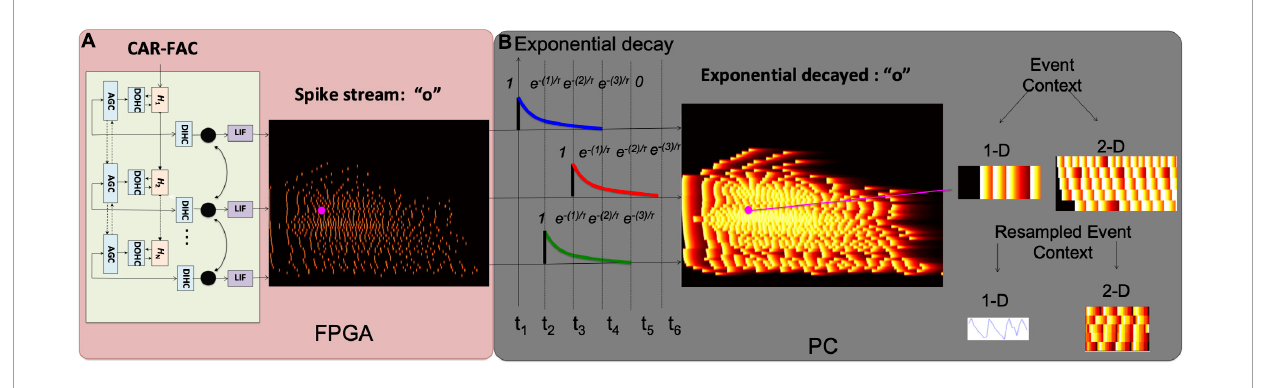
FIGURE3 Construction of the auditory time surface window. (A) Spike streams generated from the binaural CAR-FAC system on FPGA; (B) when a spike occurs in a frequency channel, the value decays exponentially as t increases, forming the exponential decaying feature. A 1-D/2-D event context (E_C) is generated on a local neighborhood centered on the current event (in magenta). The 1-D E_C provides temporal feature extraction, and the 2-D E_C provides spectrotemporal feature extraction. The E_Cs are resampled to form a uniform size for all the events as described in the text.